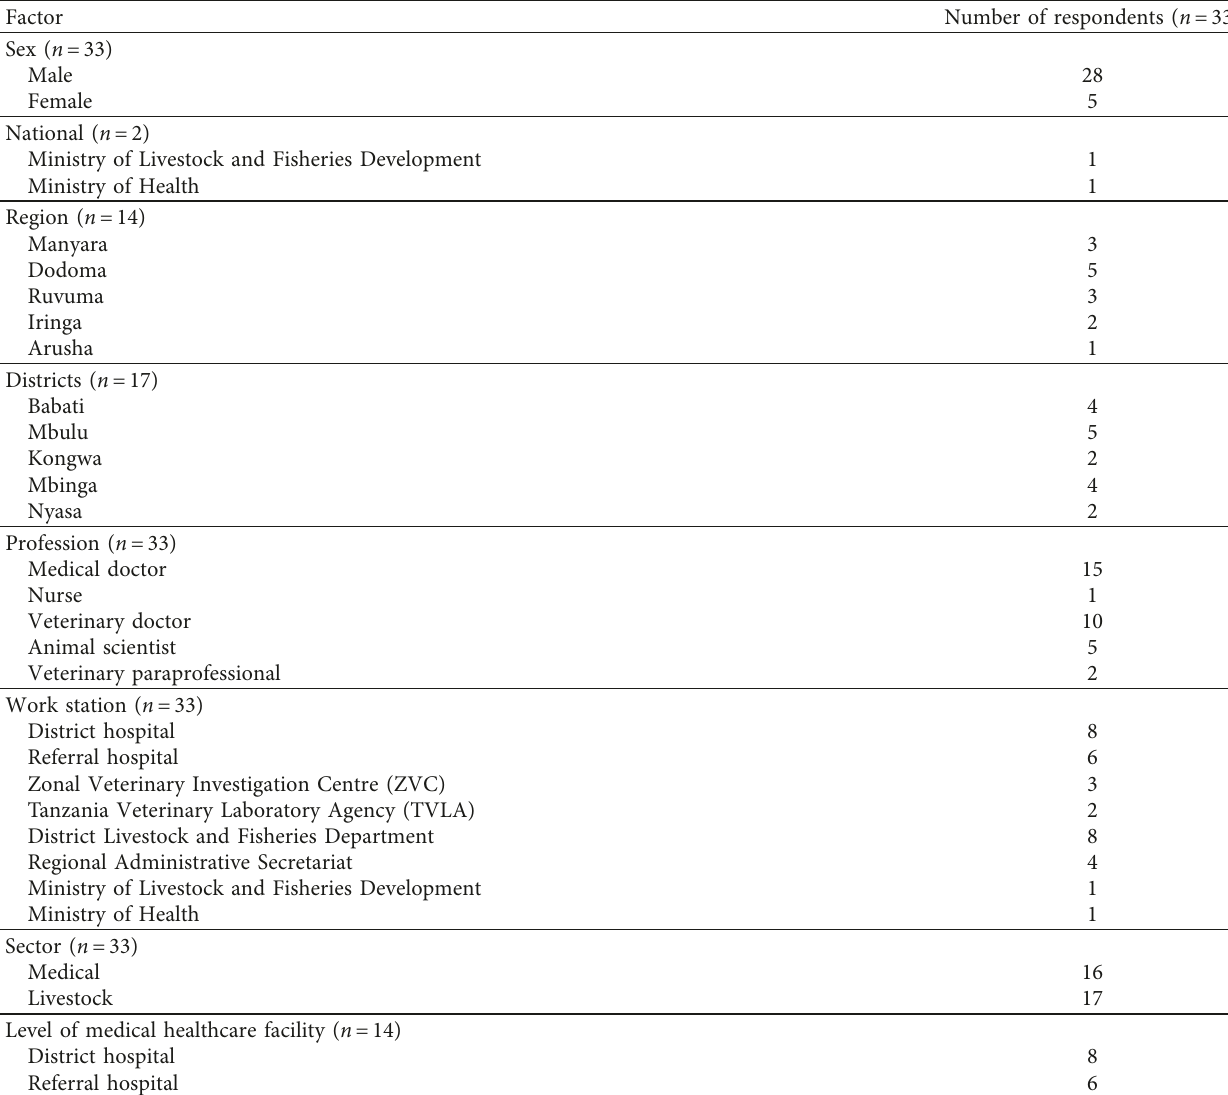
Table 6: Distribution by geographical and administration levels of study